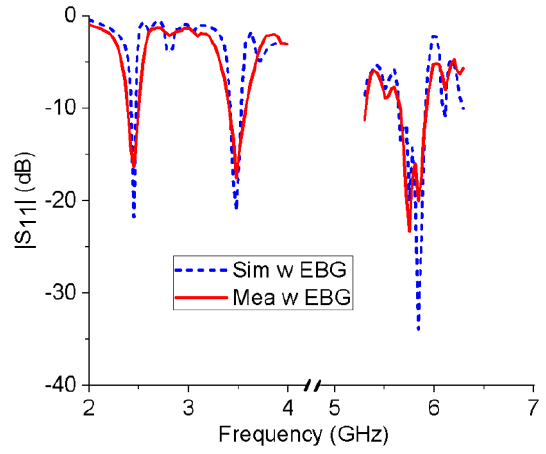
Figure 10. Simulated and measured reflection coefficients of the integrated antenna.